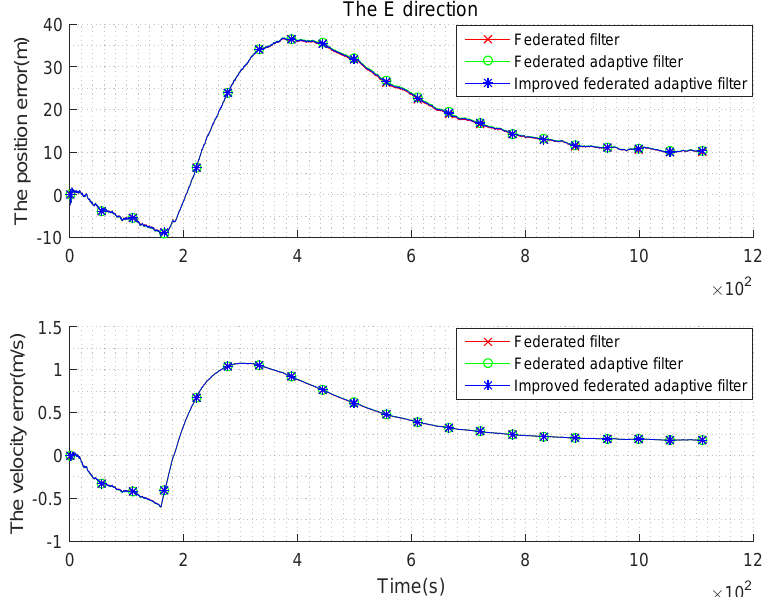
Figure 4. Comparison of the navigation error with Gaussian state noise and unbiased estimation in E direction.